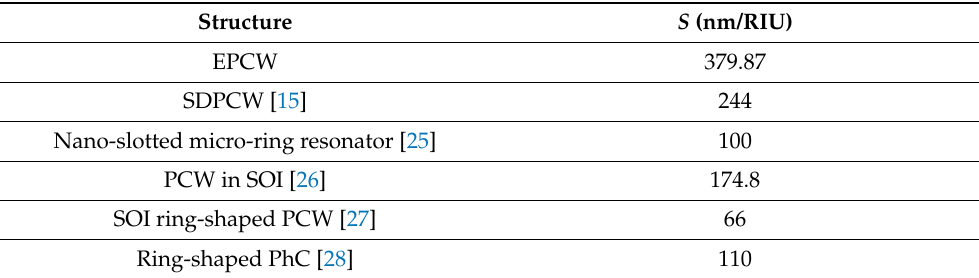
Table 2. Comparison of RI sensitivity in EPCW with previous studies based on the conventional